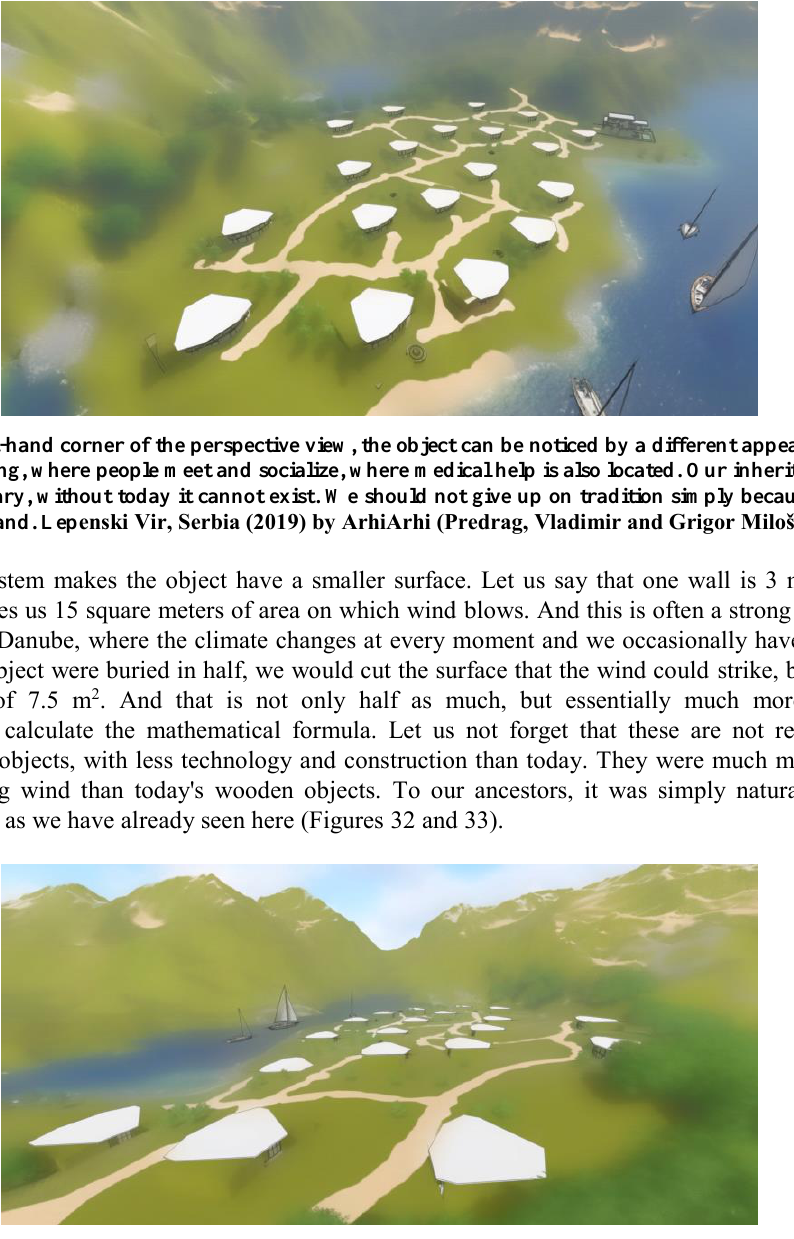
Figure 32. A perspective view showing the relationship between the level of the land and the roofs of objects. With green rooftops we can restore nature to what has been covered on the ground. Our ancestors could do it as well, and maybe they did it in the prehistoric Lepenski Vir. Lepenski Vir, Serbia (2019) by ArhiArhi (Predrag, Vladimir and Grigor